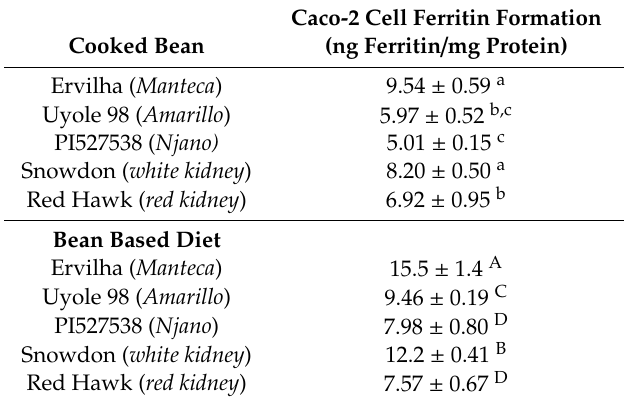
Table 6. Iron Bioavailability of Cooked Beans and Bean Based Diets Using an in vitro Digestion / Caco-2 Cell Bioassay.